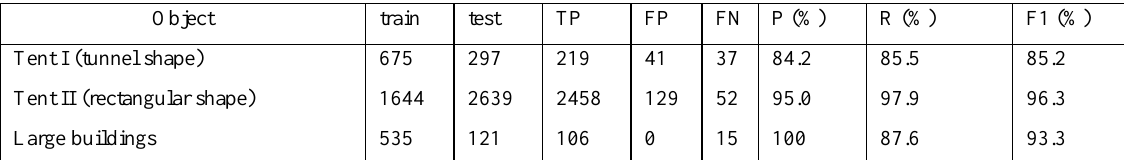
Table 1. Accuracy results of CNN approach